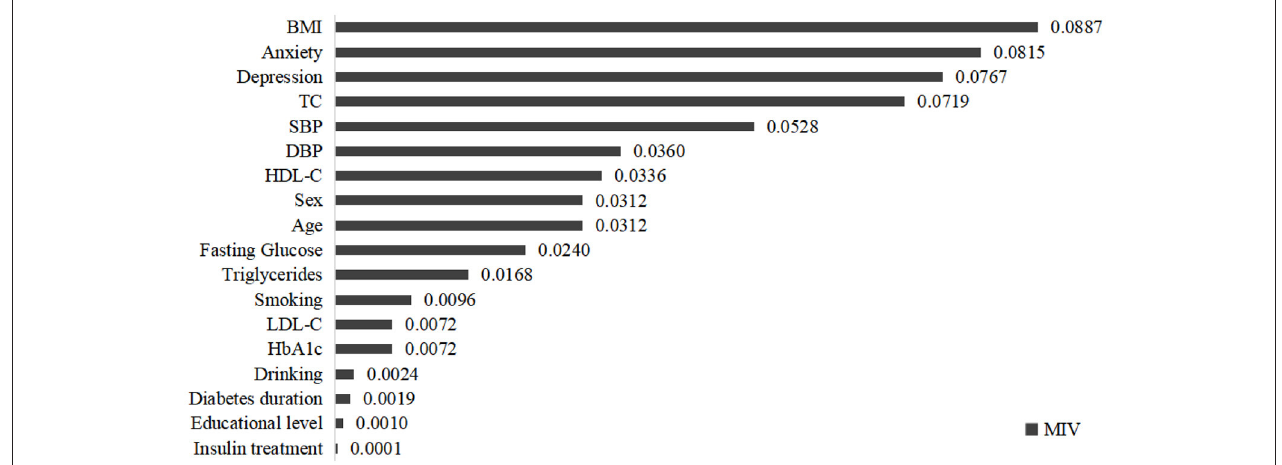
FIGURE 2 | The mean impact values of independent variables in CVD risk prediction